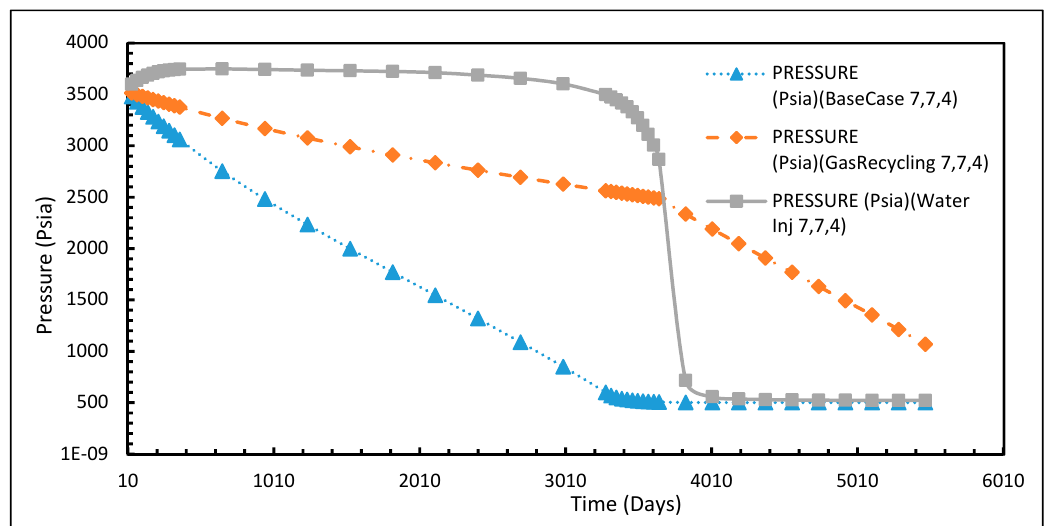
Figure 4. Reservoir pressure versus time at the wellbore block for the base, gas recycling, and water injection cases.